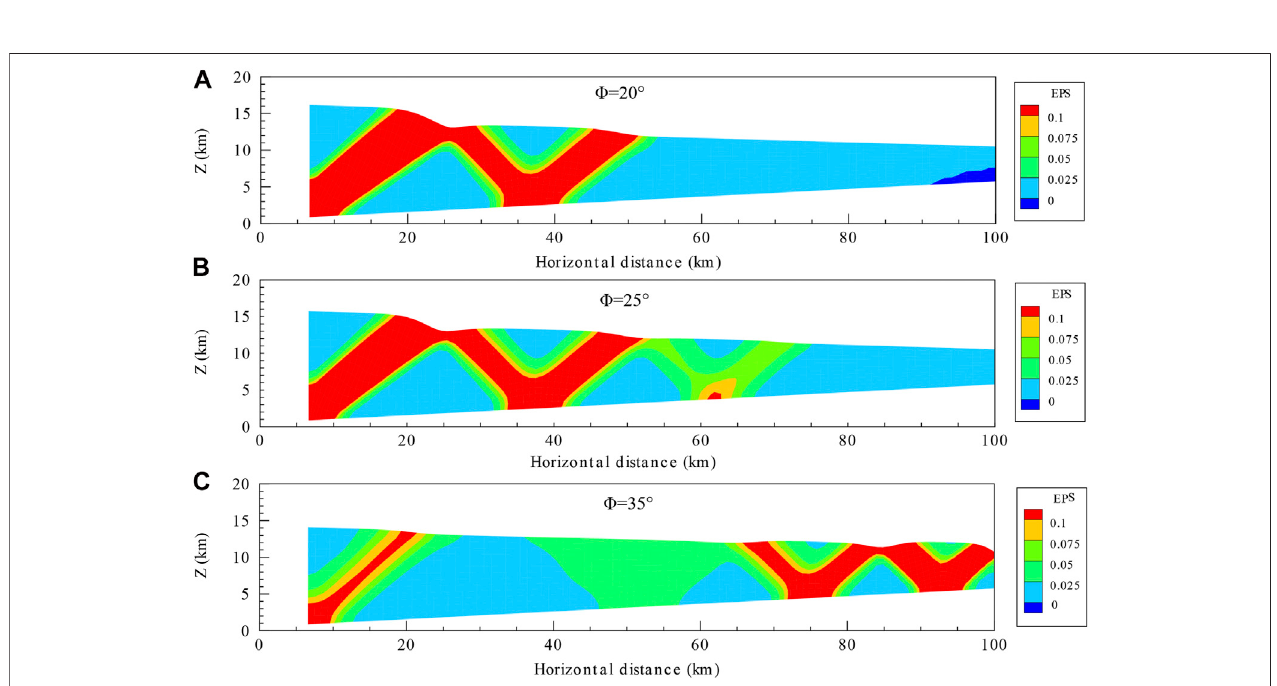
FIGURE10 | Final state EPS for models with differentinternal friction angles Φ .After 6.6 kmof shortening displacement, panels (A – C) show states ofmodels 7, 8, and 9, which have internal friction angles β (cid:1) (20, 25, and 35 ° ), respectively. Plasticity concentration patterns are different among them. High friction angles tend to drastically decrease extent and intensity of plasticity in wedge ’ s thick region and strongly favor it in its thin region.